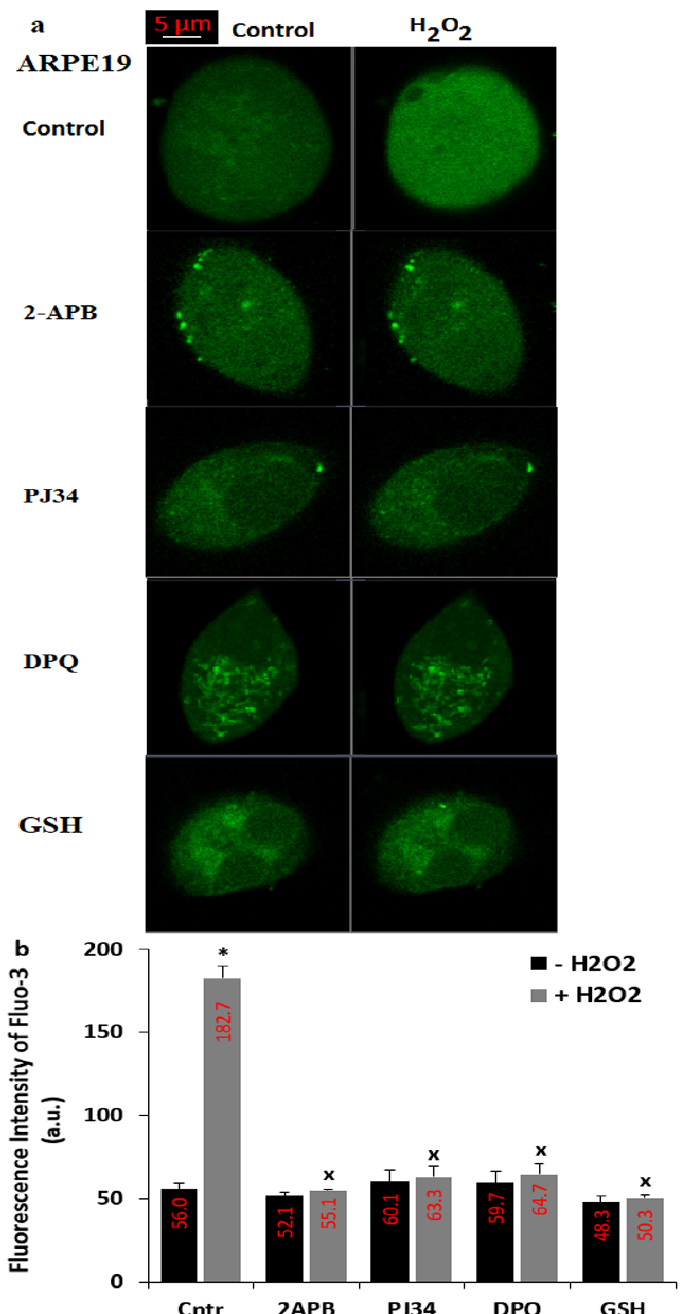
Figure 3. There is no H 2 O 2 -mediated florescence change via TRPM2 activation in the presence of GSH, PARP-1, and TRPM2 blockers. (Mean ± SD). The ARPE19 cells in the dishes were incubated with Fluo-3AM (1 µ M for 60 min.). After pre-incubation of cells with the inhibitors of PARP-1 (1 µ M PJ34 and 30 µ M DPQ), TRPM2 (100 µ M 2APB for 30 min) and GSH (10 mM for 2 h), the cells were stimulated by H 2 O 2 (1 mM for 6 min). The symbolic images ( a ) and the mean intensity values ( b ) of the [Ca 2+ ] c from the groups of control (Cntr), 2APB, PJ34, DPQ and GSH groups were obtained. The images were captured in the LSM 800 laser confocal microscope with 40 × 1.3 oil objective and the results of Fluo-3AM florescence intensity were indicated as arbitrary unit (a.u.). The scale bar: 5 µ m. One symbolic image from each group was selected from 25–30 cells of 6 independent investigations. (* p ≤ 0.05 vs. Cntr ( − H 2 O 2 ) group. x p ≤ 0.05 vs. vs. Cntr (+ H 2 O 2 )